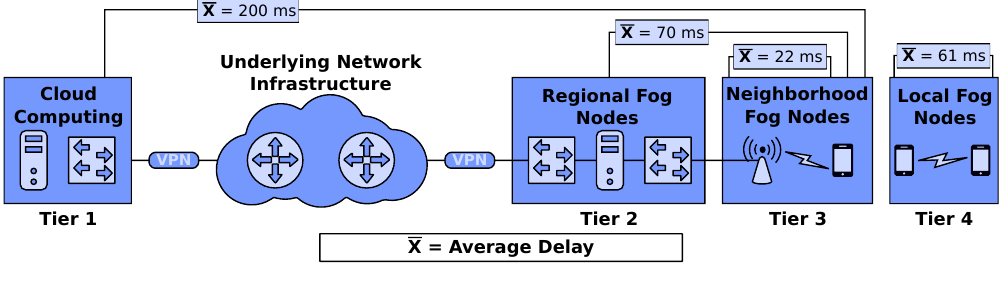
Figure 3. Experimental